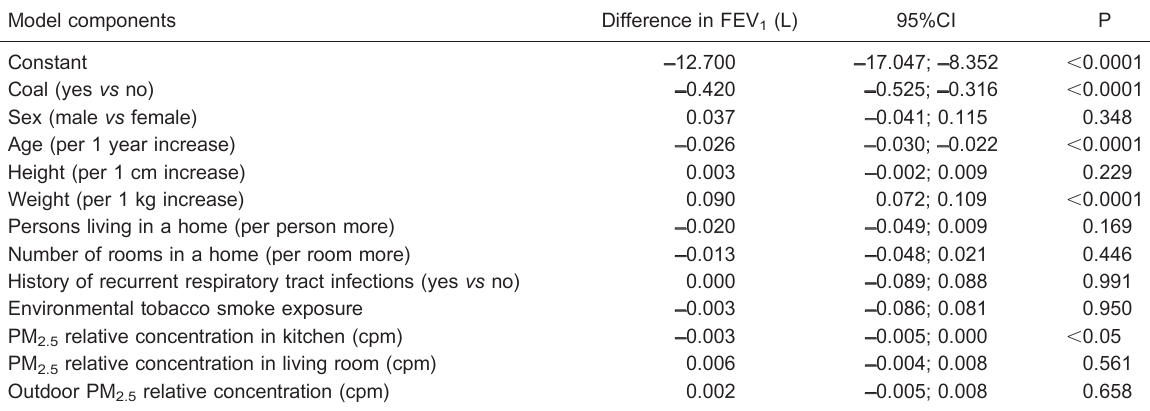
Table 3. Estimated parameters and 95% confidence interval (CI) of multivariate linear regression analysis of forced expiratory volume (FEV 1 ) in 1 s.